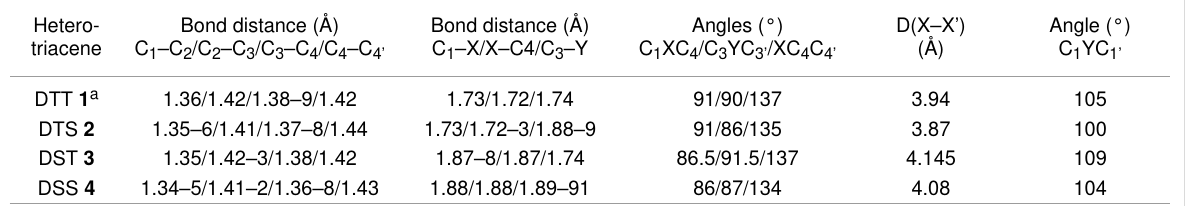
Table 1: Bond distances, bond angles, and distances D of the outer heteroatoms obtained from the single crystal X-ray structure analysis of heterotri- acenes 1 to 4 . Hetero-